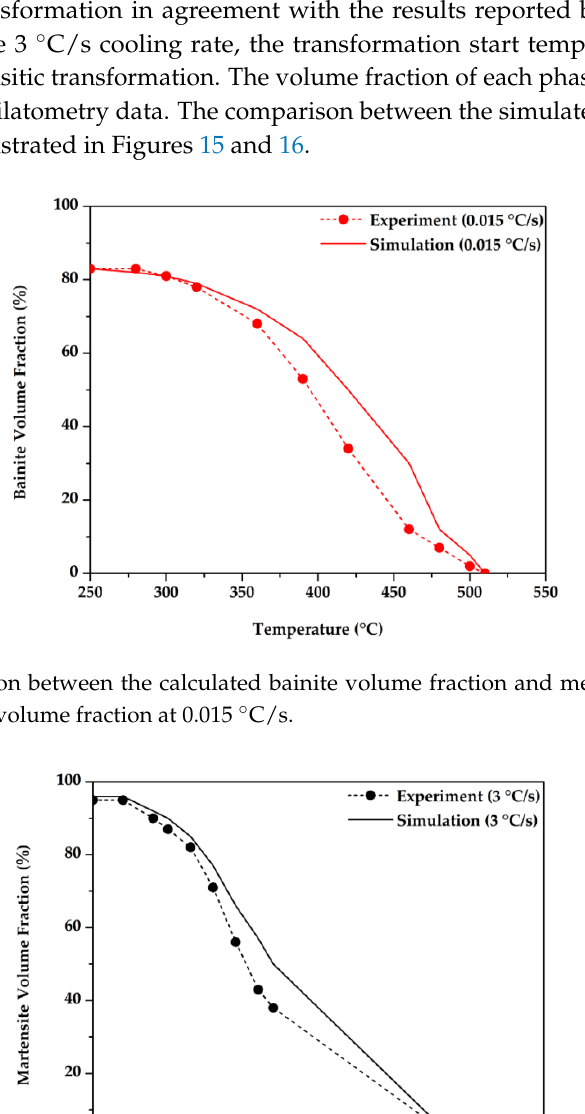
Figure 17. SEM images of the obtained microstructure after cooling: ( a ) Martensite at 3 °C/s; ( b ) Bainite at 0.015 °C/s.